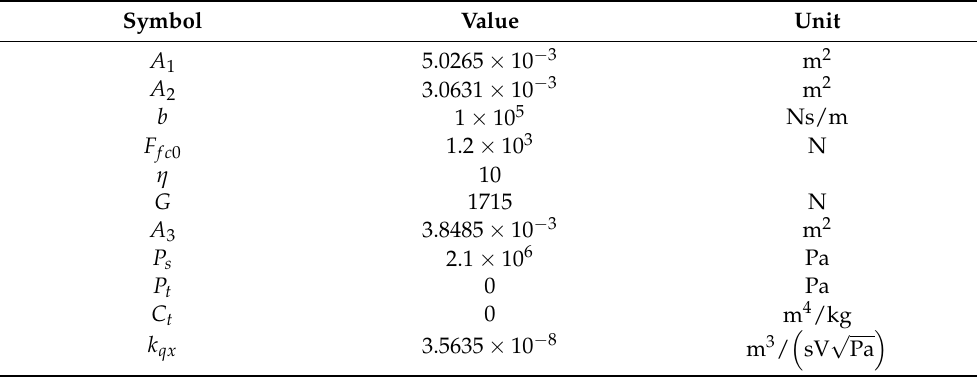
Table 3. Parameters of the electro-hydraulic system.